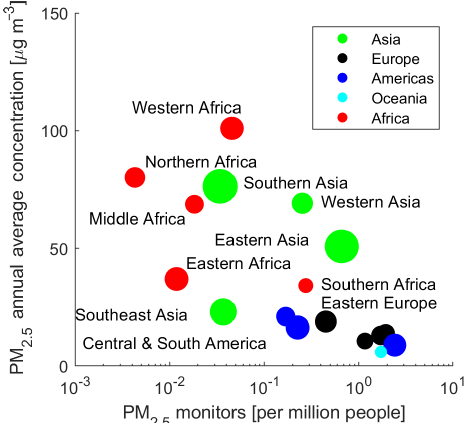
Figure 1. Estimated annual average PM 2 . 5 concentration versus the density of regulatory-grade monitoring stations across several global regions. Colors correspond to continents, and sizes roughly correspond to total regional population. This graphic is based on information available from the Global Health Observatory (WHO,